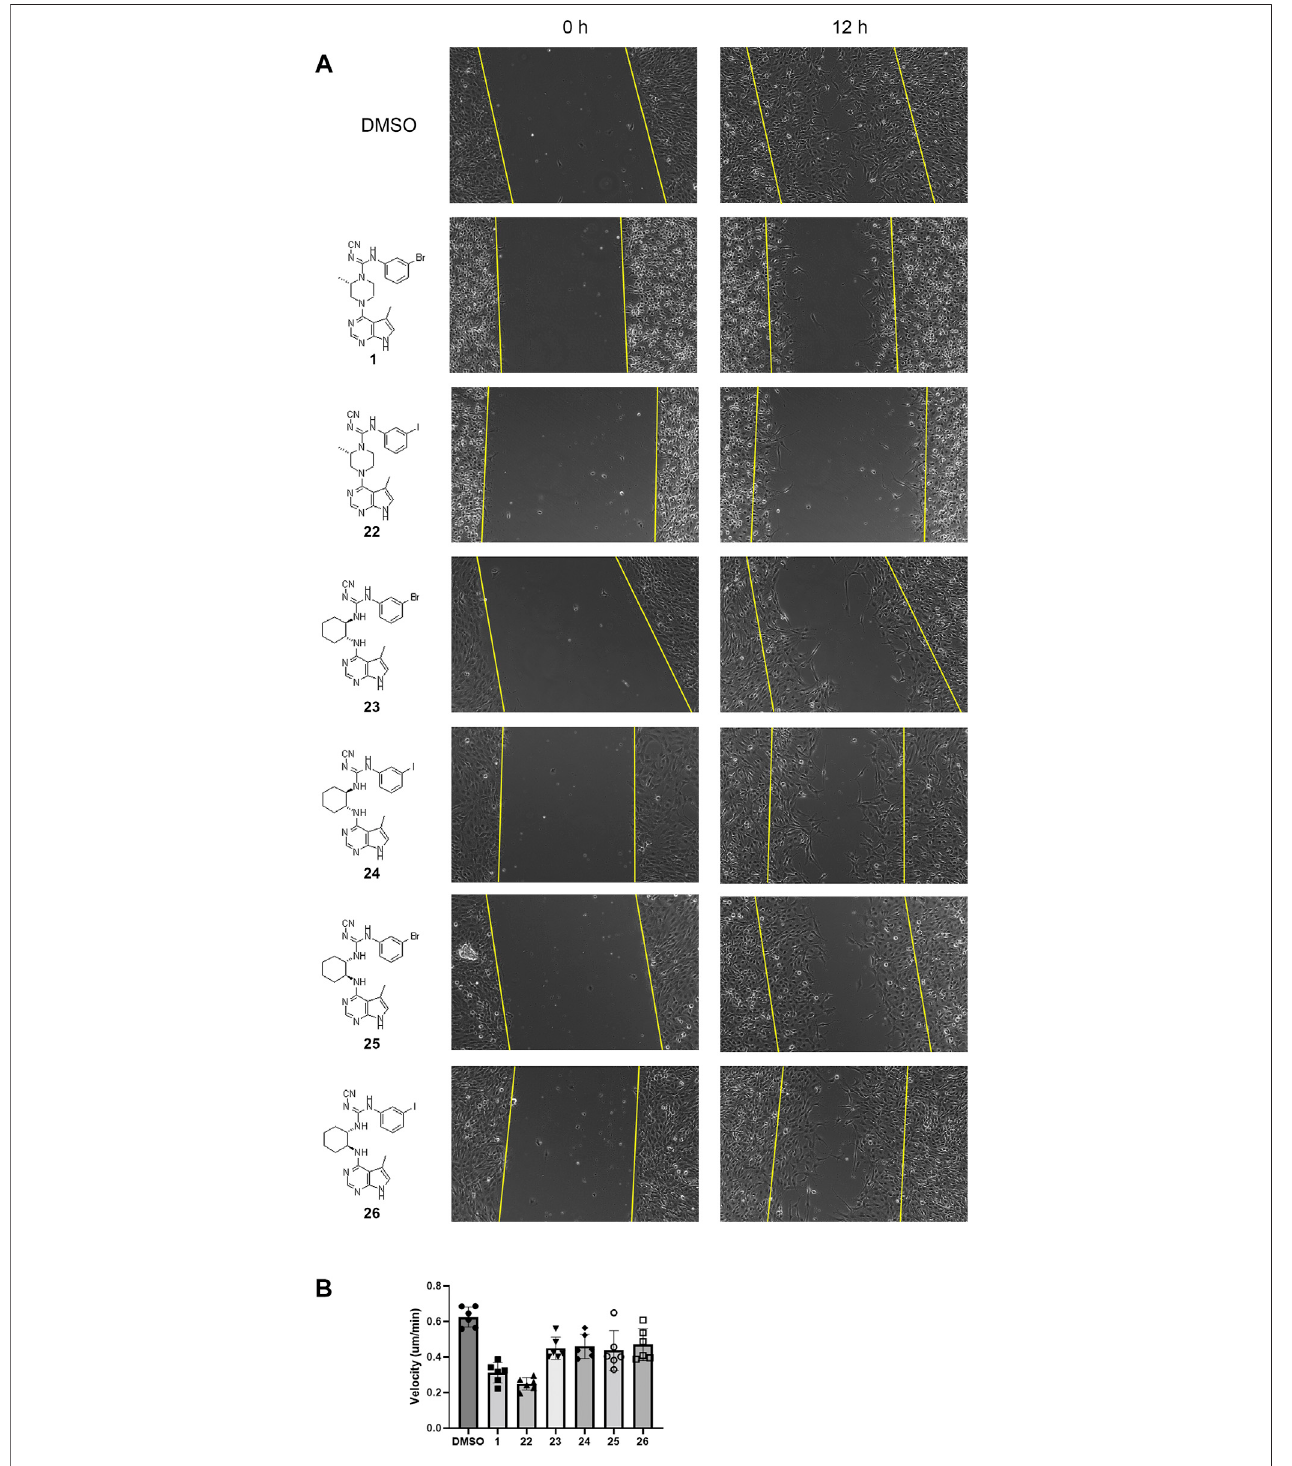
FIGURE 3 | Delayed wound closure in scratch assays upon LIMK inhibition. (A) Representative scratch assay images at 0 and 12 h for compounds 1 and 22 – 26 . Yellow lines indicate the edges of the scratch wound and therefore starting point of cell migration. (B) Quanti fi cation of cell velocity from six independent experiments using single-cell tracing.